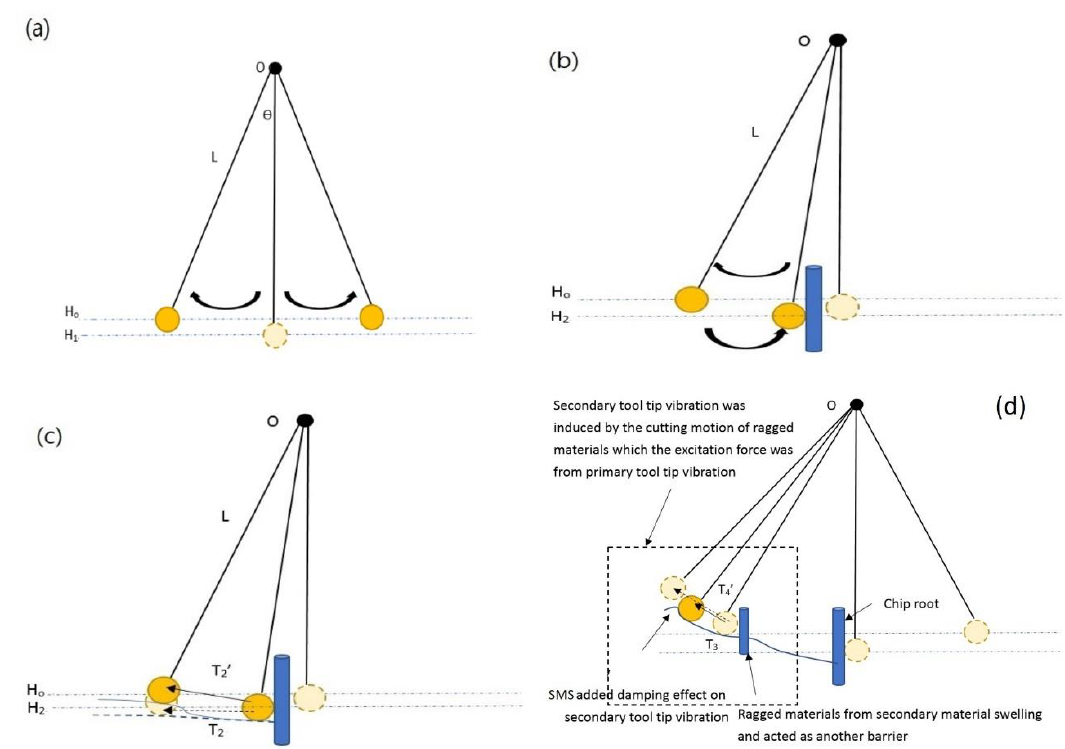
Figure 2. ( a ) The free pendulum system without an impact ( b ) the impact pendulum system without the damping effect and ( c ) the impact pendulum system with the damping effect. ( d ) The illustration graph of tool tip vibration induced by the ragged materials from secondary material swelling (SMS) and the corresponding damping effect.